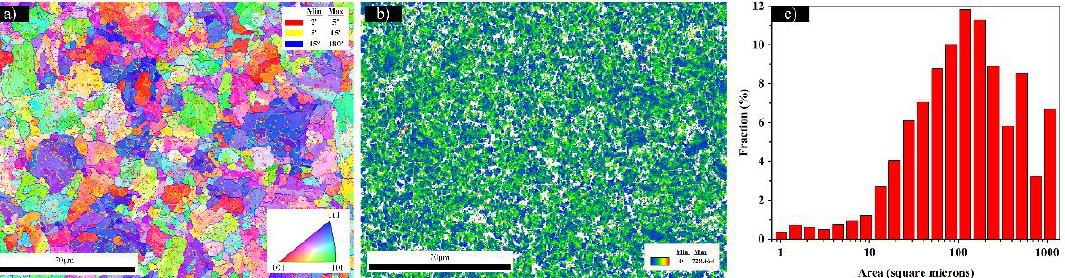
Figure 14. Microstructure information of sample A. ( a ) EBSD orientation map; ( b ) GND map; ( c ) grain area distribution.